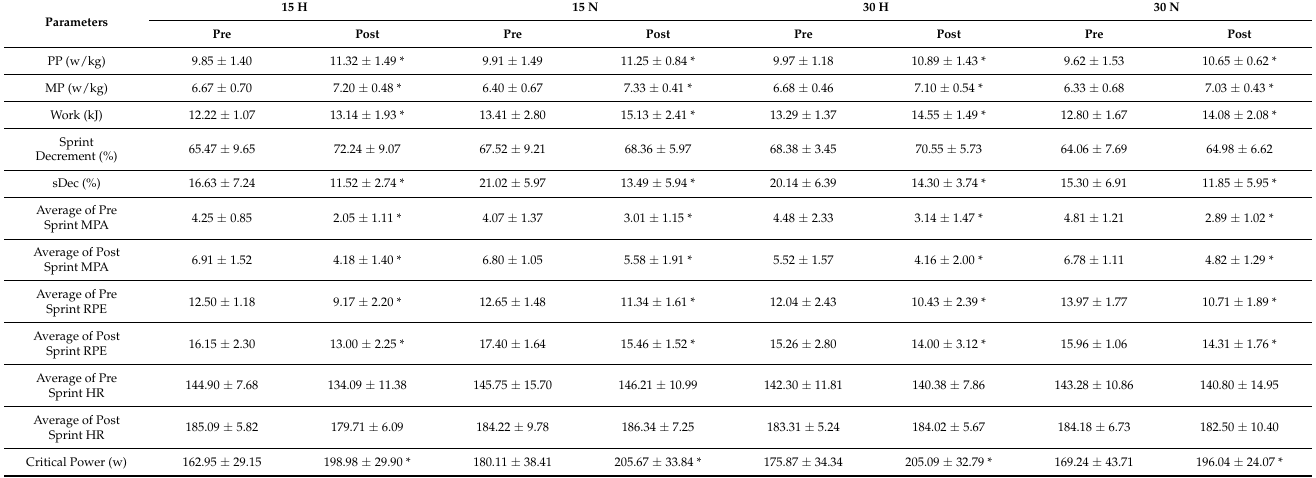
Table 3. Repeated wingate and critical power